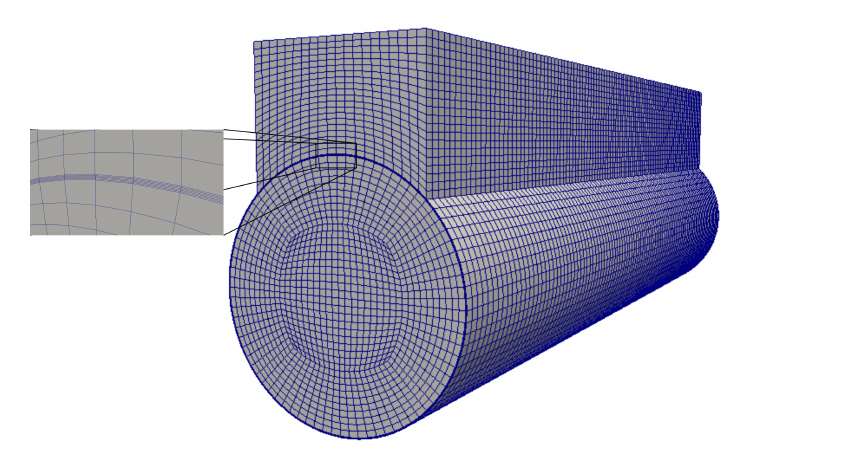
Figure 3. Structured background mesh for cylinder and piston meshing. Detail of gap meshing with five layers is also shown.